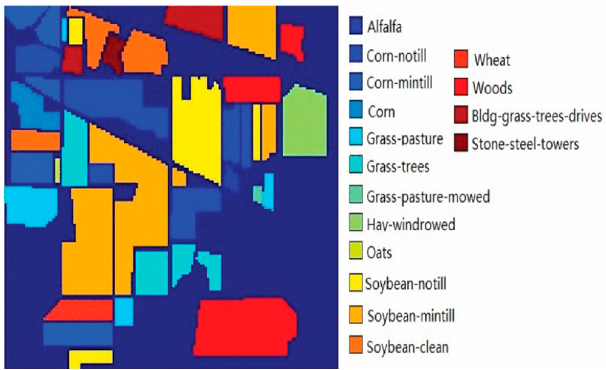
Figure 2. Ground truth of the Indian Pines data set.